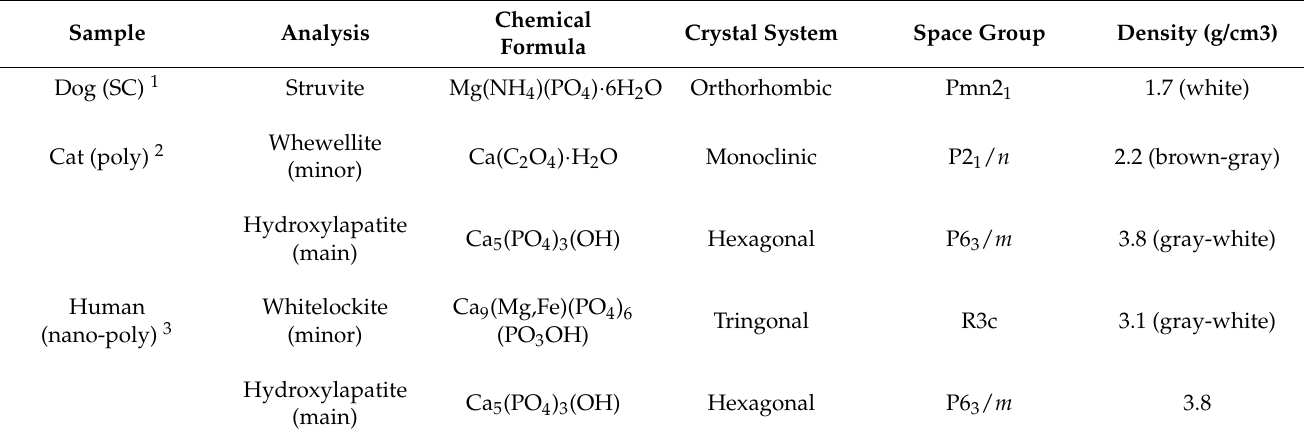
Table 1. Composition and phase analysis of urinary stones by the XRD method.